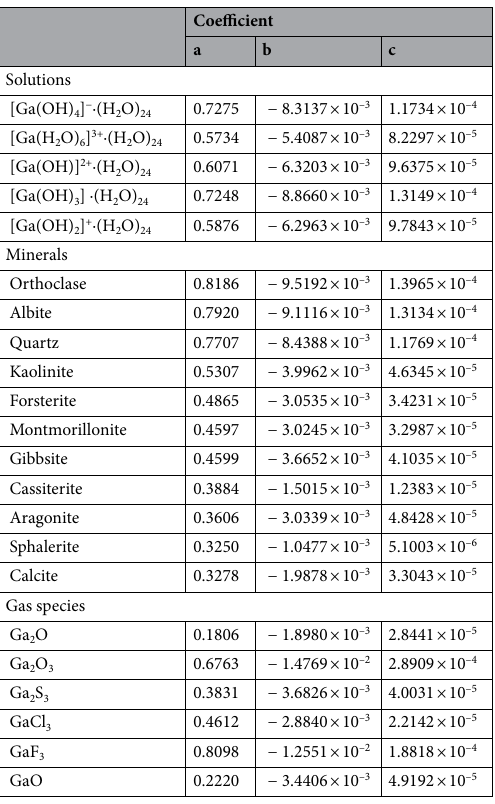
Table 2. Polynomial expansions of the RPFR factors ( 71 Ga/ 69 Ga) of different Ga-bearing species based on